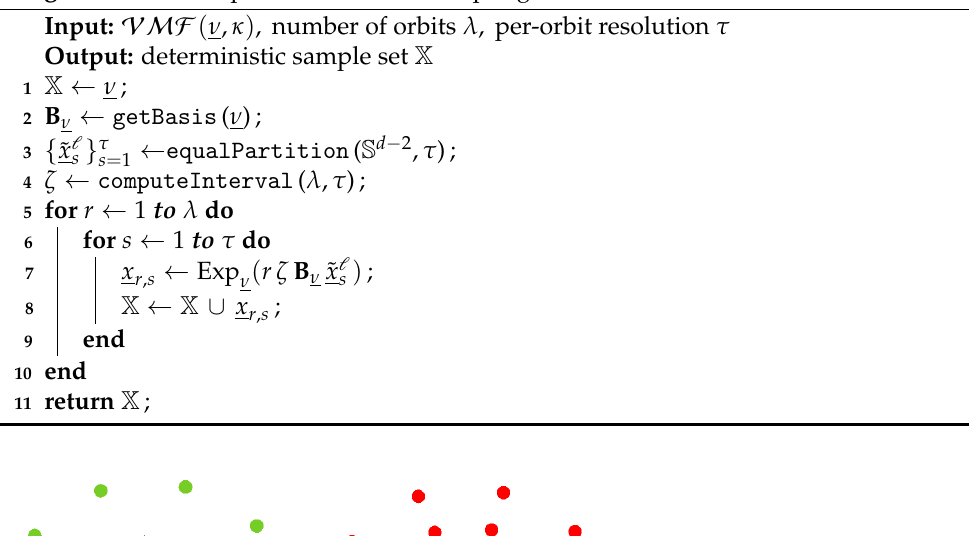
Algorithm 1: Isotropic Deterministic Sampling